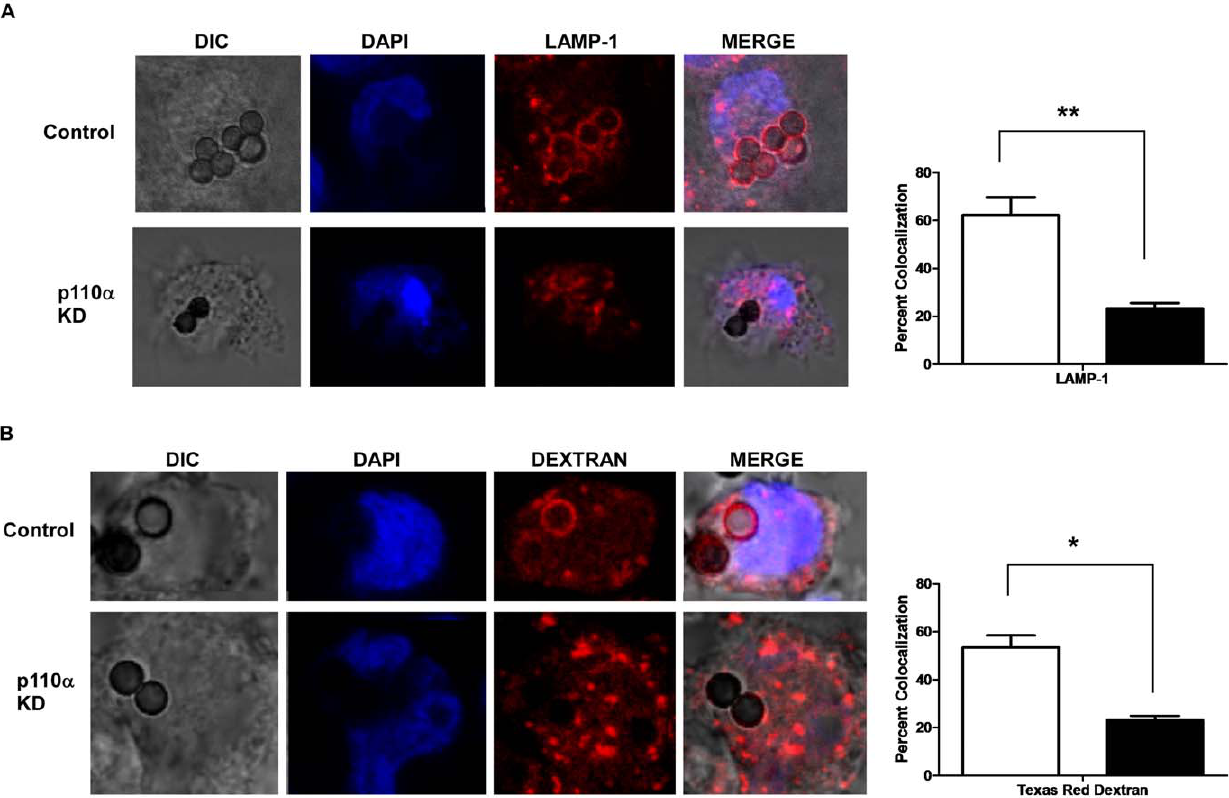
Figure 4. Phagosomes from p110 a knockdown cells show marked decreases in LAMP-1 acquisition and phagolysosome fusion. A) Confocal microscopy of control and p110 a knockdown cells shows reduced phagosomal LAMP-1 acquisition. The graph to the right shows counts of phagosomes colocalized with LAMP-1 staining. At least 100 phagosomes in each of three independent experiments were counted. Open bar = Control cells, Solid bar = p110 a knockdown cells. Means + / 2 s.e.m. are shown. **p , 0.01. B) Confocal microscopy of control and p110 a knockdown cells shows reduced phagosome - lysosome fusion. Cells were loaded with Texas Red dextran, which was then chased into lysosomes. The graph to the right shows the numbers of phagosomes that were positive for a dextran signal. At least 100 phagosomes in each of three independent experiments were counted. Open bar = control cells, Solid bar = p110 a knockdown cells. Means + / 2 s.e.m. are shown. *p , 0.05.